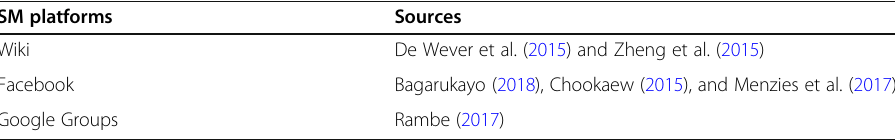
Table 3 Sampled sources with studied SM